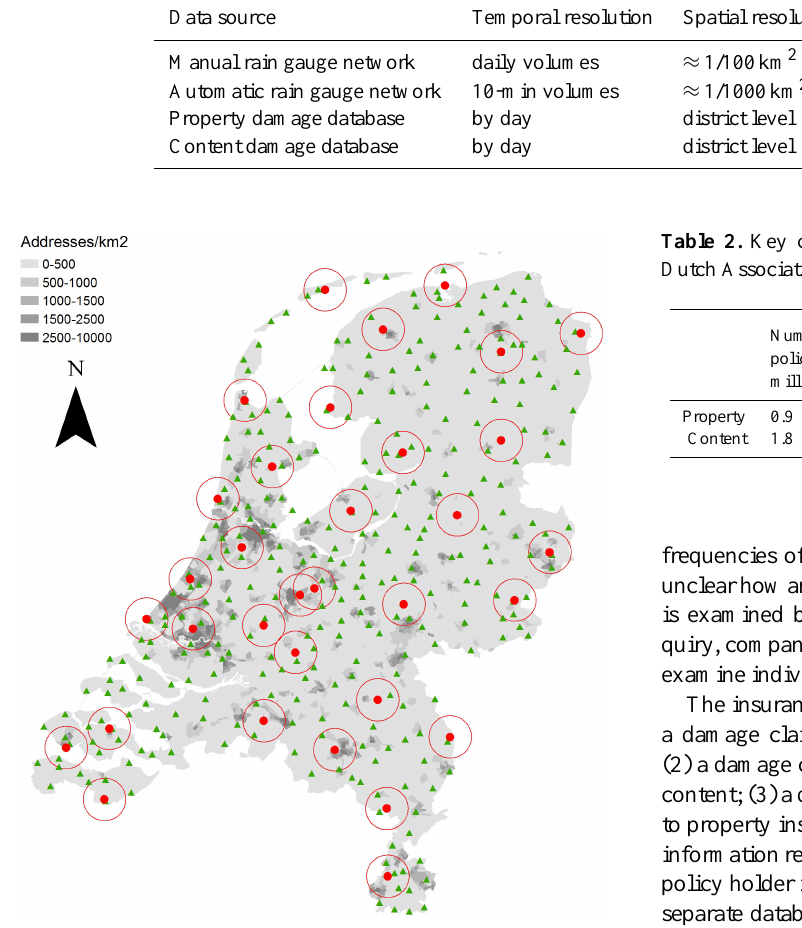
Fig. 1. Locations of 33 automatic rain gauges (solid circles) and 300+ manual rain gauges (triangular markers) and the area within a 10-km radius of automatic rain gauges (open circles). Urban den- sity (addresses/km 2 ) is presented in grey scales.